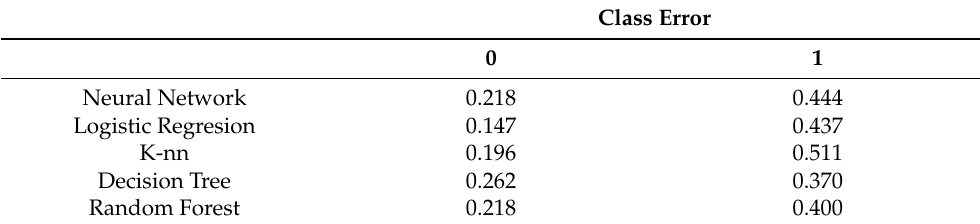
Table 3. Class error for each algorithm implemented, based on confusion